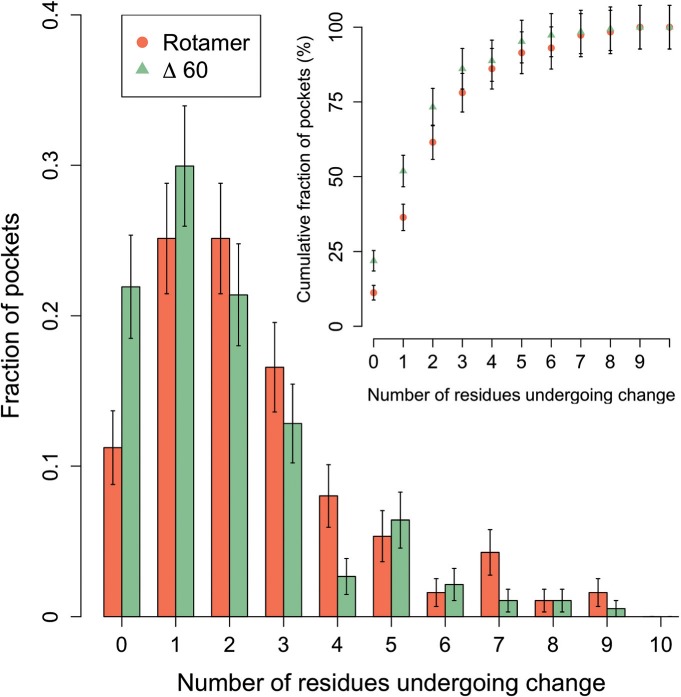
Distribution of the number of residues undergoing conformational changes in binding-sites. Nearly 88% of binding sites contain at least one side chain undergoing rotamer conformational change (orange). At most five side chains undergo conformational change in ~90% of binding-sites (inset). Green bars/triangles show the results obtained using and angular difference threshold of 60° as the criteria for the occurrence of conformational changes